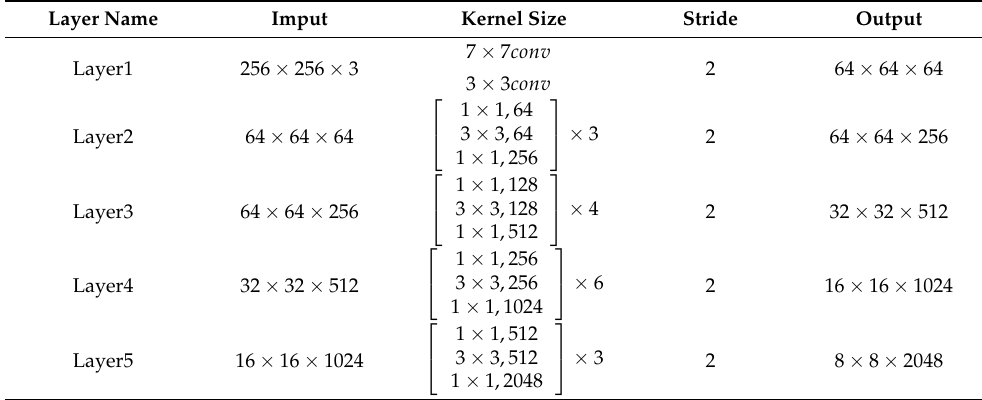
Table 1. ResNet detailed parameter settings.